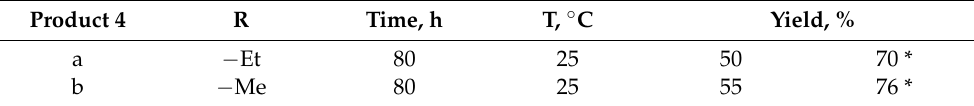
Table 1. The optimized reaction conditions and yields of products 4, prepared according to Scheme 1.